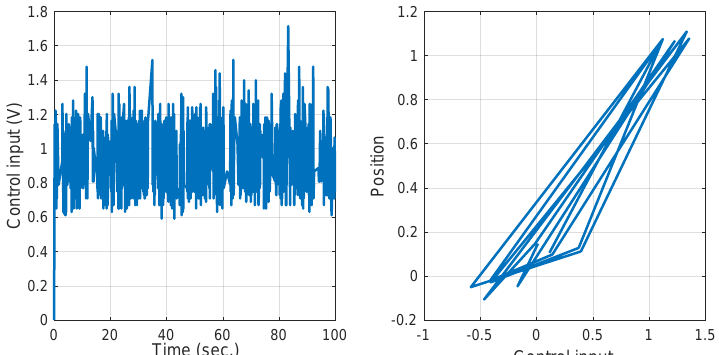
Figure 8. Control effort and the corresponding hysteresis for the anti-windup control (8), along